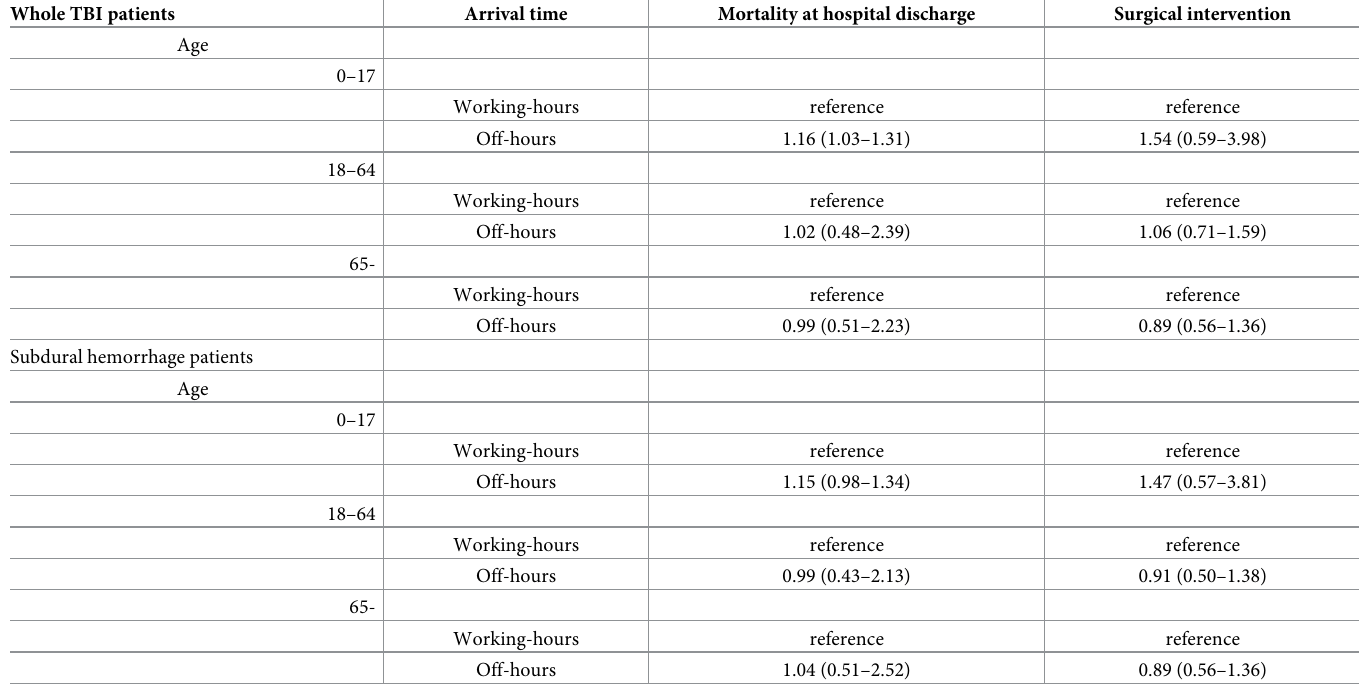
Table 4. Interaction analysis between the arrival time at emergency department and age